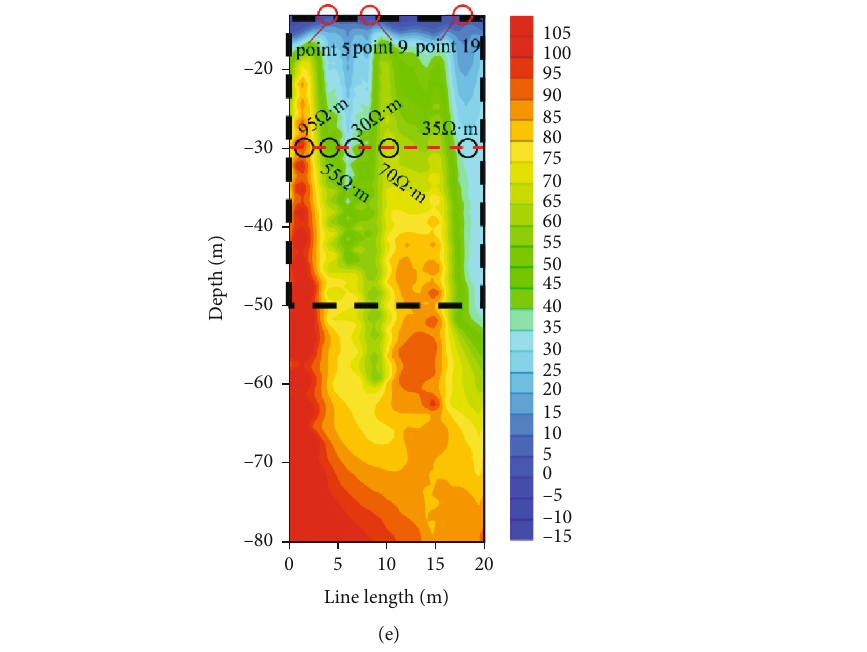
Figure 6: The apparent resistivity pro fi le of di ff erent survey lines: (a) survey line 1; (b) survey line 2; (c) survey line 3; (d) survey line 4; (e) survey line